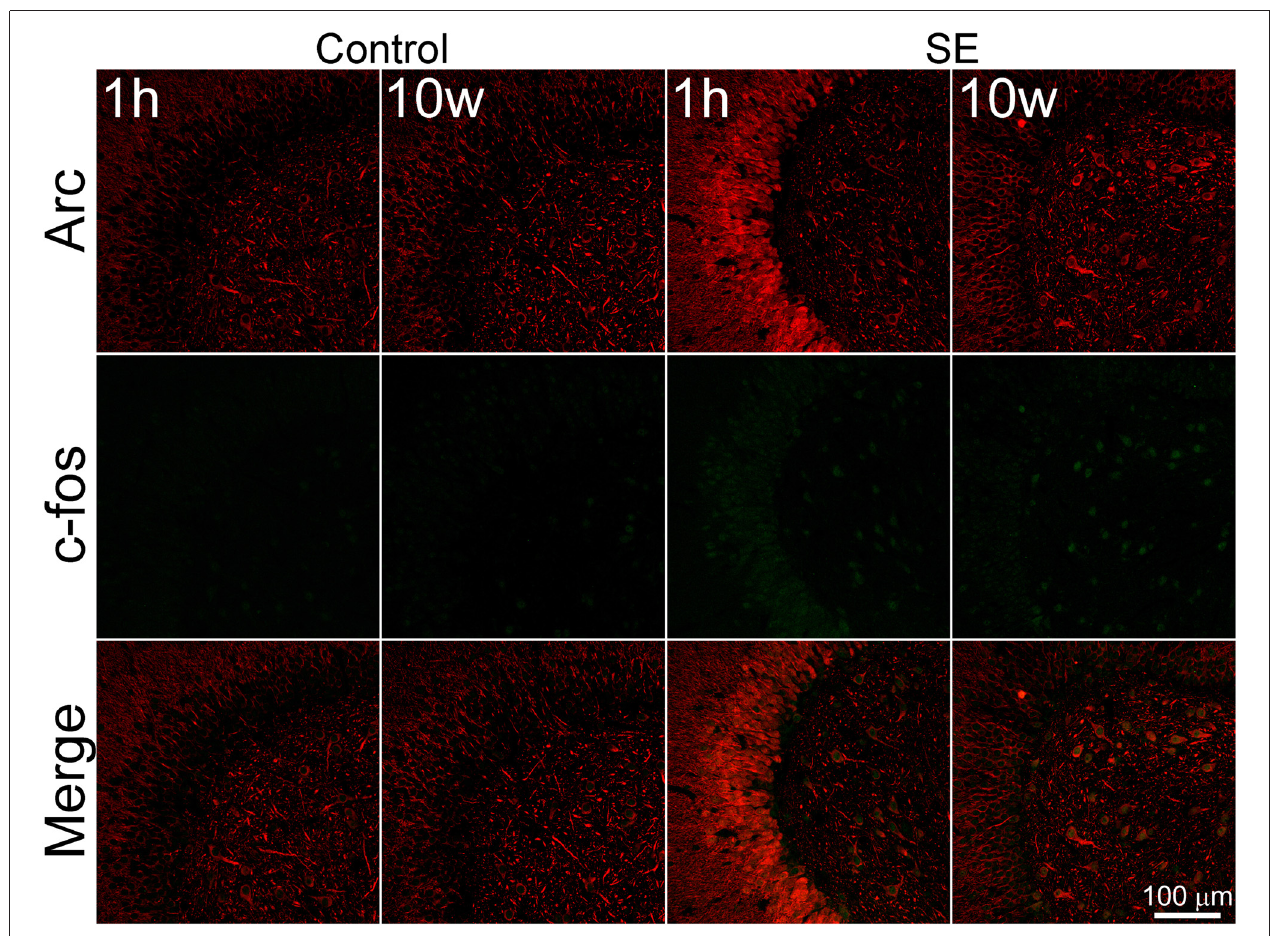
FIGURE 1 | Arc and c-fos are expressed in the same cells with parallel densities but different subcellular locations in both the controls and animals suffered from pilocarpine-induced status epilepticus (SE) . SE was induced by an intraperitoneal injection of pilocarpine and animals in the control group (Control) received equivalent amount of normal saline. Animals were sacrificed 1 h after the termination of a 2-h SE (indicated by 1 h) or more than 10 weeks after SE (indicated by 10 W). Horizontal hippocampal sections were double-stained with a goat anti-c-fos and rabbit anti-Arc and scanned with a confocal microscopy. Scale bar = 100 µ m (applicable to all